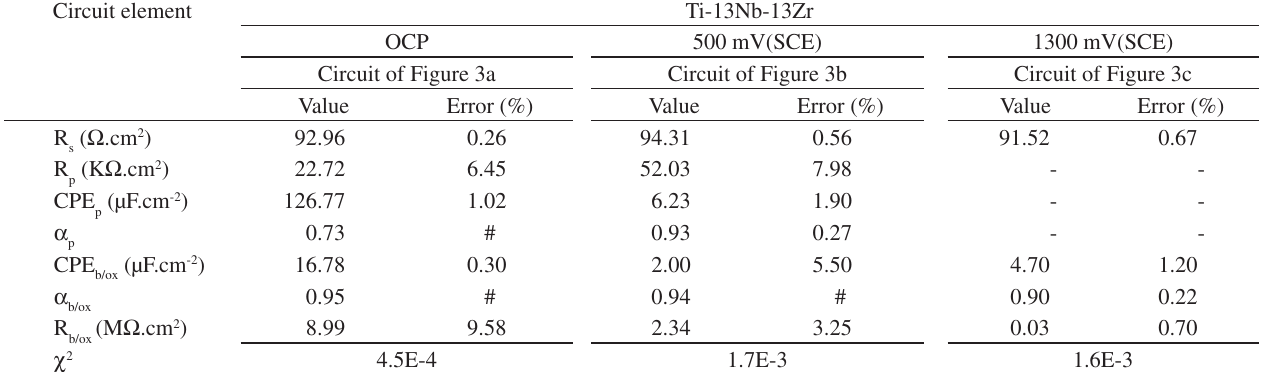
Table 3. Values of electrical components obtained from fitting the circuits shown in Figure 3 to the experimental results from electrochemical impedance tests for 72 hours immersion in Hanks’ solution at 37 ºC of Ti-13Nb-13Zr alloy at three potentials. Circuit